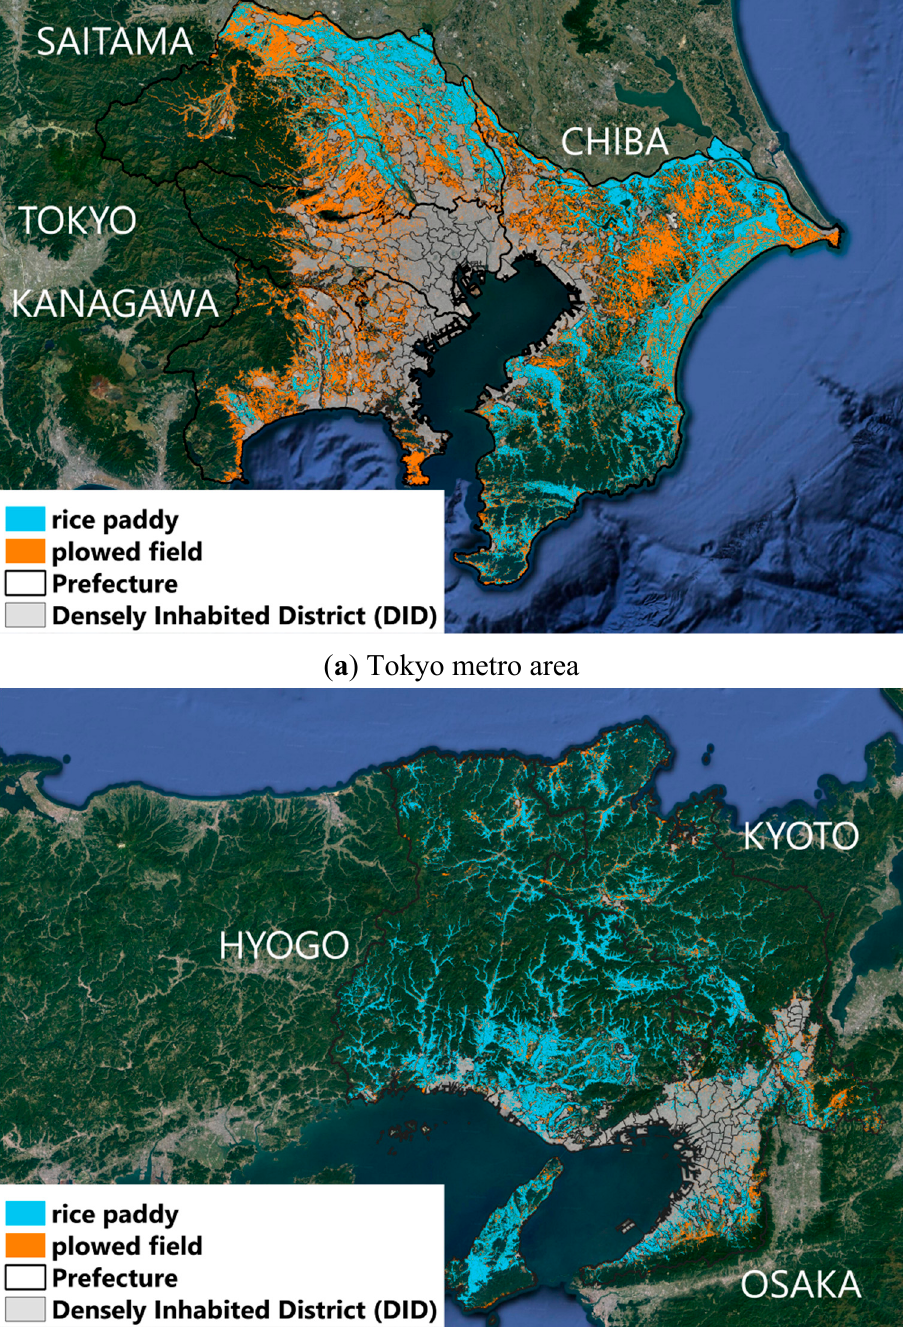
Figure 3. Distribution maps of farmland parcels. ( a ) shows Tokyo metro area and ( b ) shows Osaka metro area. Sources: National Land Information of Ministry of Land, Infrastructure, Transport, and Tourism of Japan. Ministry of Agriculture, Forestry, and Fisheries.